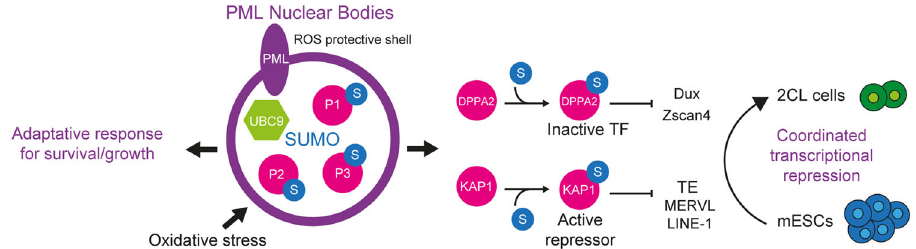
Fig.6|FunctionalimpactofPMLNB-facilitatedsumoylation. PMLNBsenhance the sumoylation of partner proteins (in pink). Through control of their sumoyla- tion,PMLcoordinatesthe activityof KAP1and DPPA2,orchestrating the inhibition